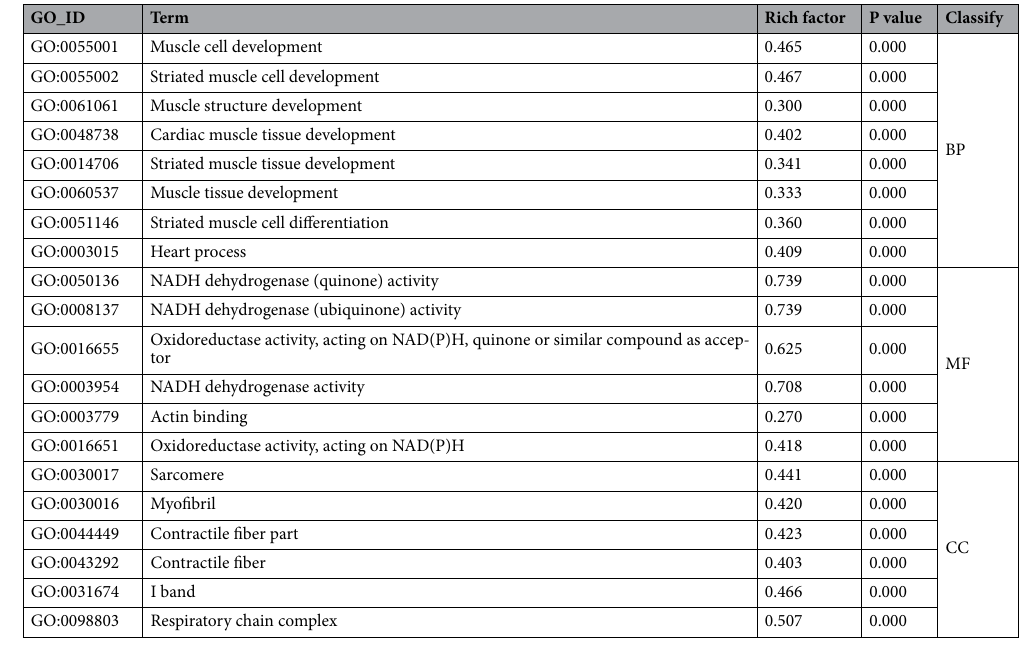
Table 1. Enriched GO terms (top